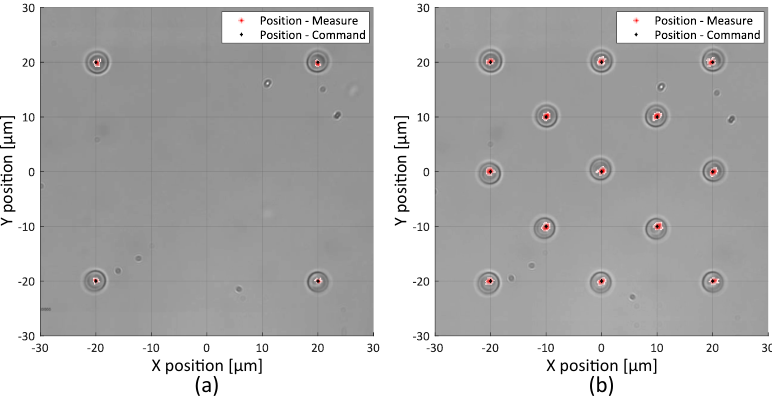
Figure 3. Static precision tasks ( a ) Four micro-beads positioned in a square of 40 × 40 µm. The maximum error between the command and the actual position is 400 nm. ( b ) Thirteen micro-beads set to cover a 40 × 40 µm square. The maximum position error is up to 1 µm and is essentially due to Brownian motion. Positions are measured during 15